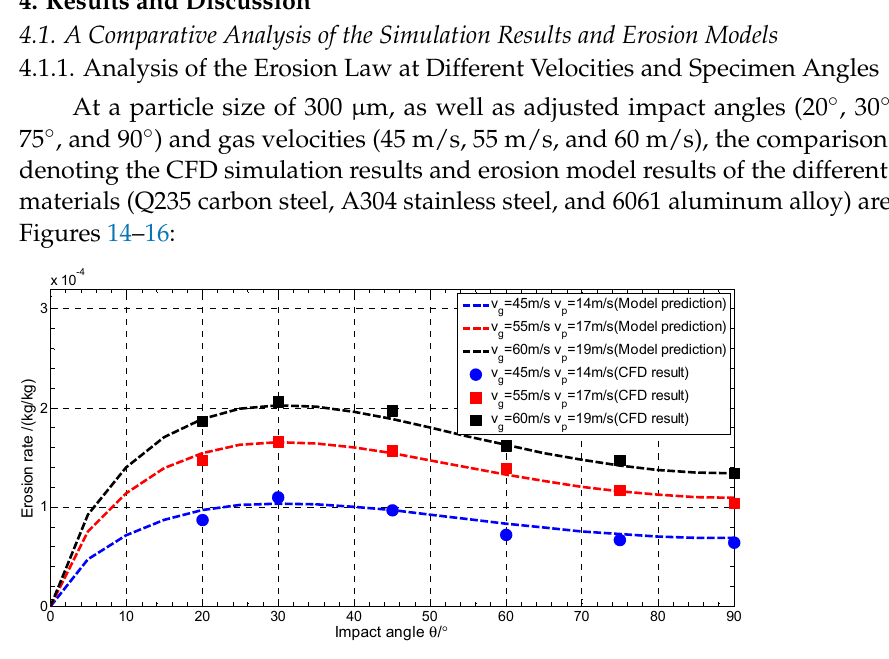
Figure 13. A comparison of the erosion depth at different velocities and particle sizes ( θ = 90°). ( a ) Depth erosion at differ- ent air velocities ( d p = 300 μ m) . ( b ) Erosion depth at different particle diameters ( v g = 60m/s).